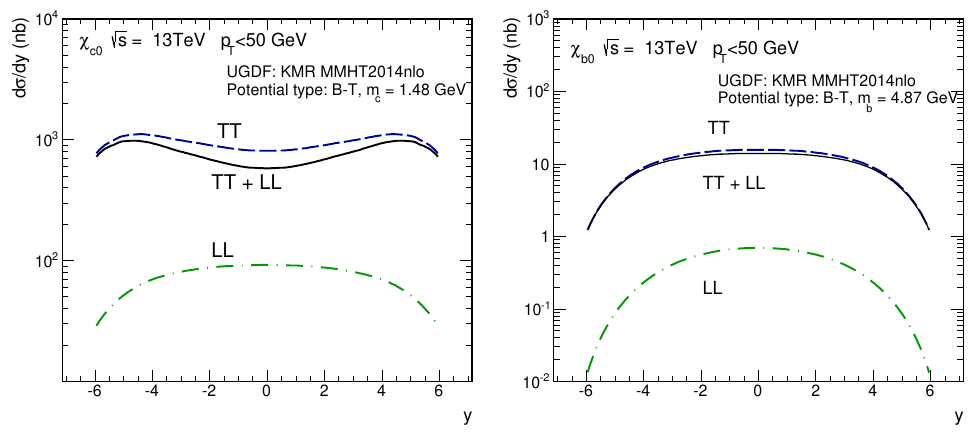
Figure 15 . The comparison of meson transverse momentum distributions with only the LL ampli- tude and only TT amplitude as well as for the full, coherent sum of TT and LL amplitudes. Here the B-T potential was used.